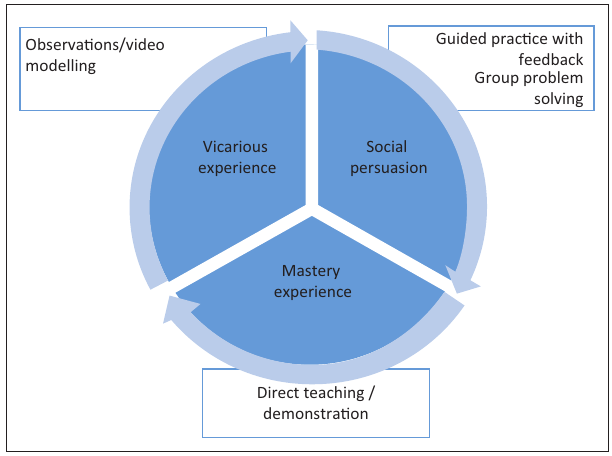
Direct teaching /